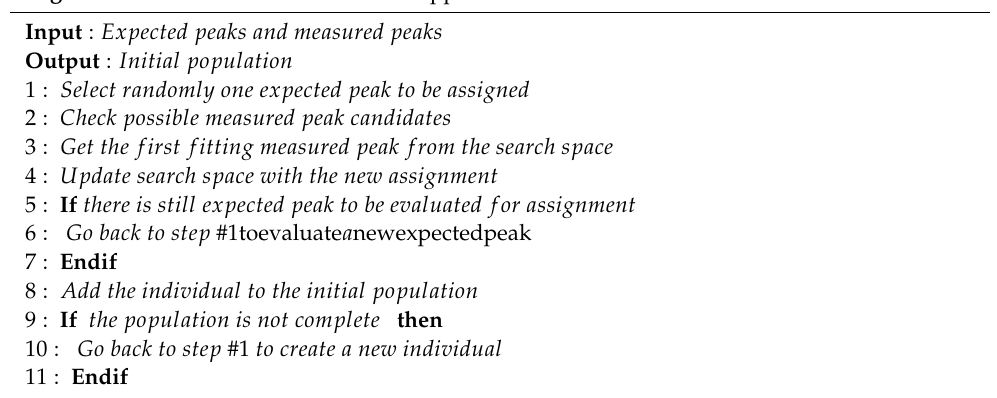
Algorithm 3 Constructive initialization